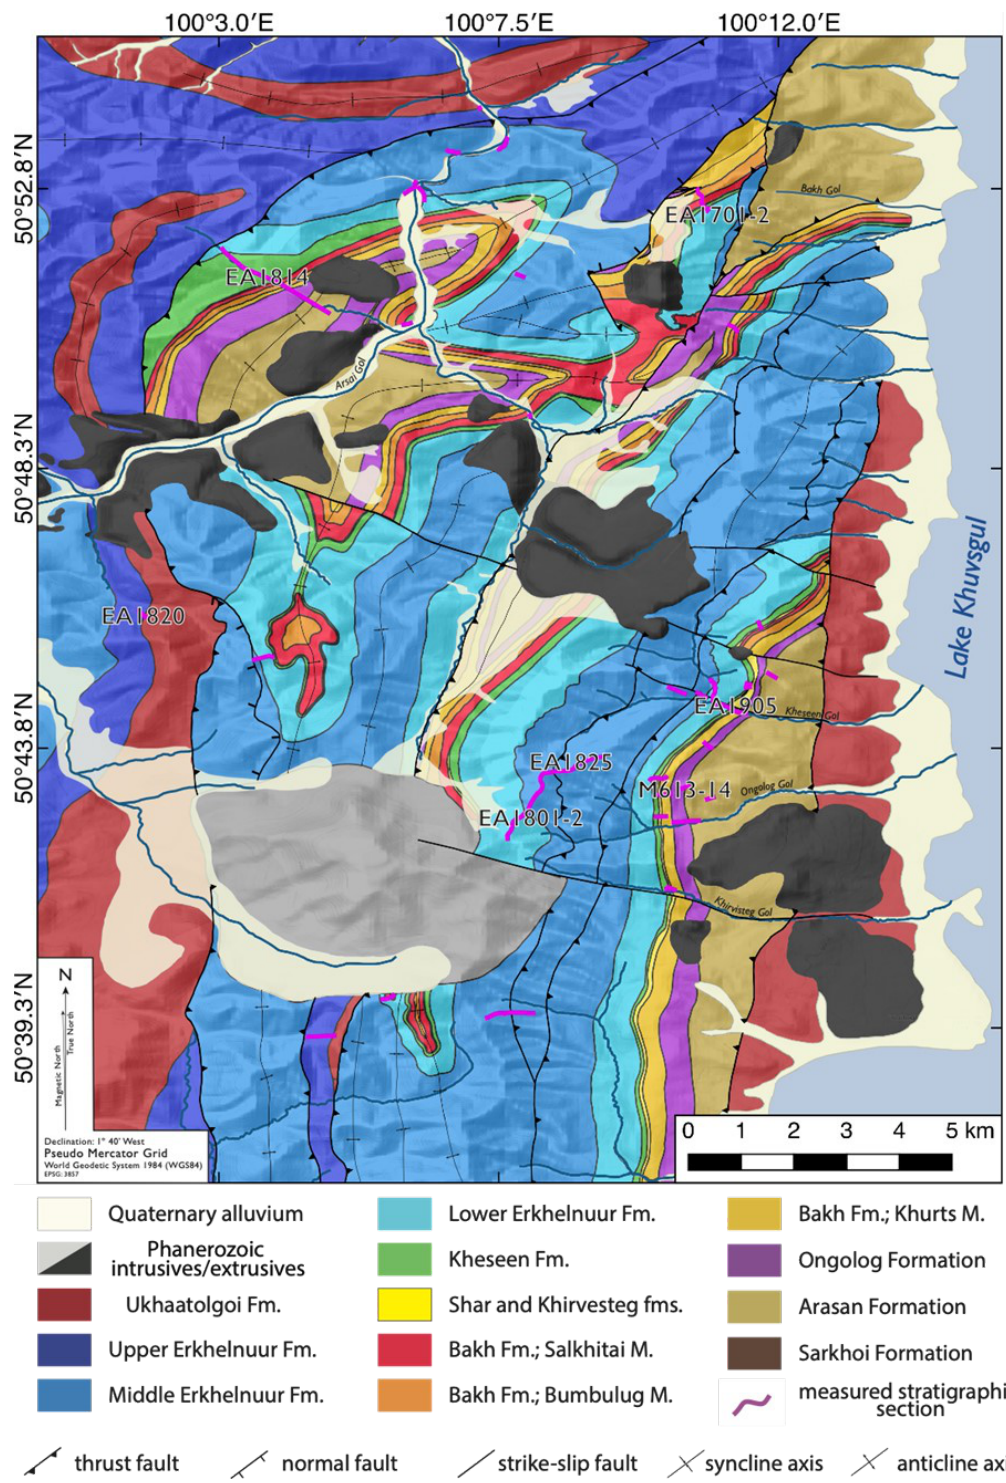
Fig. 2. Geologic map of the eastern and central Khoridol-Saridag Range, Khuvsgul Aimag, Mongolia. Locations of measured stratigraphic sections are depicted with lavender lines. Only type-locality measured sections are labeled, as are river drainages or gorges (“ gols”) relevant to locations discussed in this work. Note that the Shar Formation and Khirvesteg Formation are depicted in this figure as a single unit, as the Khirvisteg Formation is generally too thin to be clearly discernible at the map scale presented